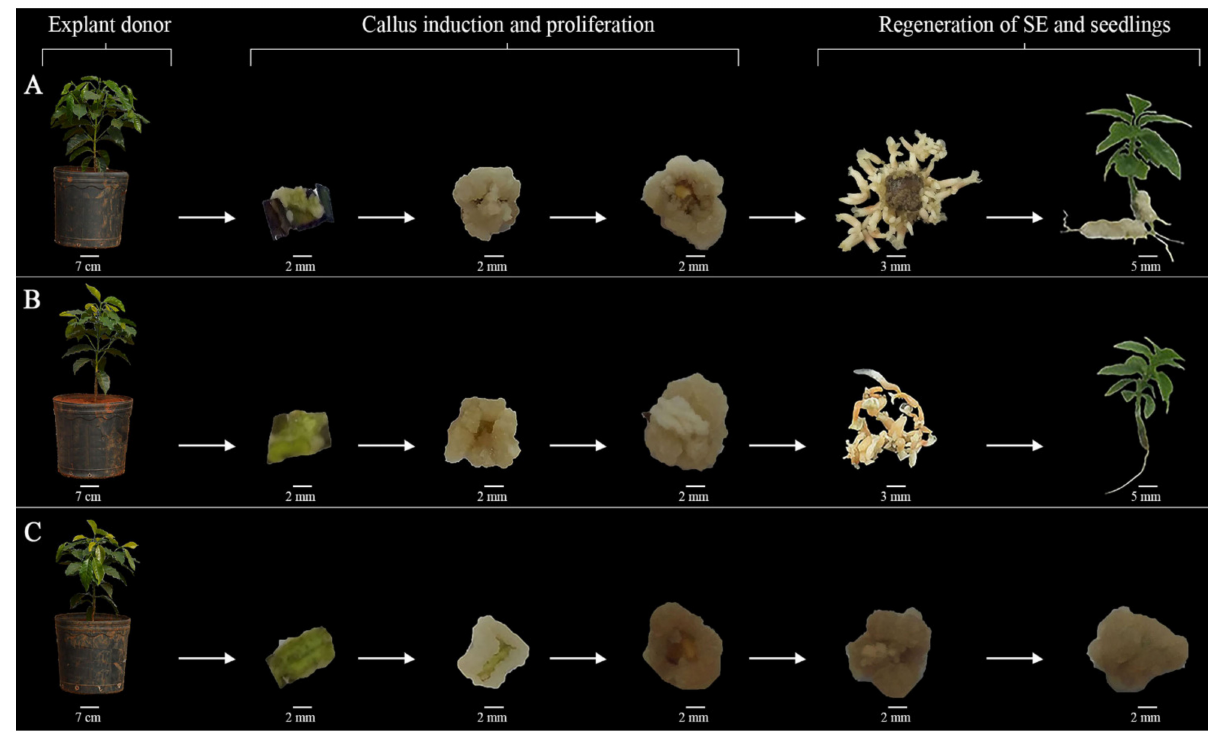
Figure 3. ISE response of the C. arabica lines during in vitro culture. ISE response was evaluated in three stages: induction and proliferation of friable calli; and regeneration of SE and seedlings. Leaf explants responded the induction and proliferation conditions, resulting in friable callus for the three lines ( A – C ). ISE was established for ‘Catua í Vermelho’ and ‘Caturra’, acquiring embryogenic competence and regenerating plants ( A , B ). ISE was not stablished for ‘Oeiras’, remaining in friable callus